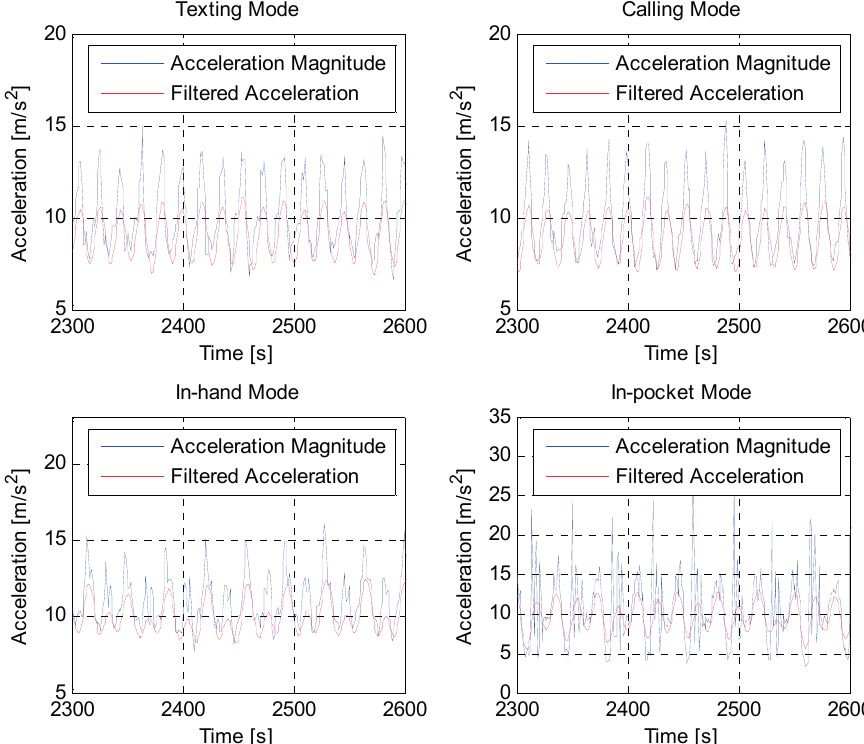
Figure 3. Acceleration magnitudes during normal walking in different carrying contexts and their corresponding filtered signals.